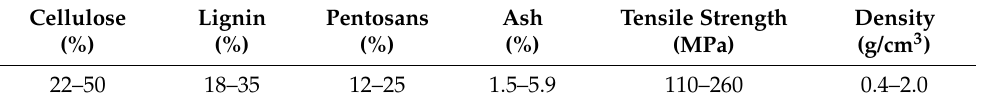
Figure 2. Selected stalked bamboo fibre strips for composite fabrication. Table 2. Some important information on chemical and physical properties of bamboo fibres [21,22].